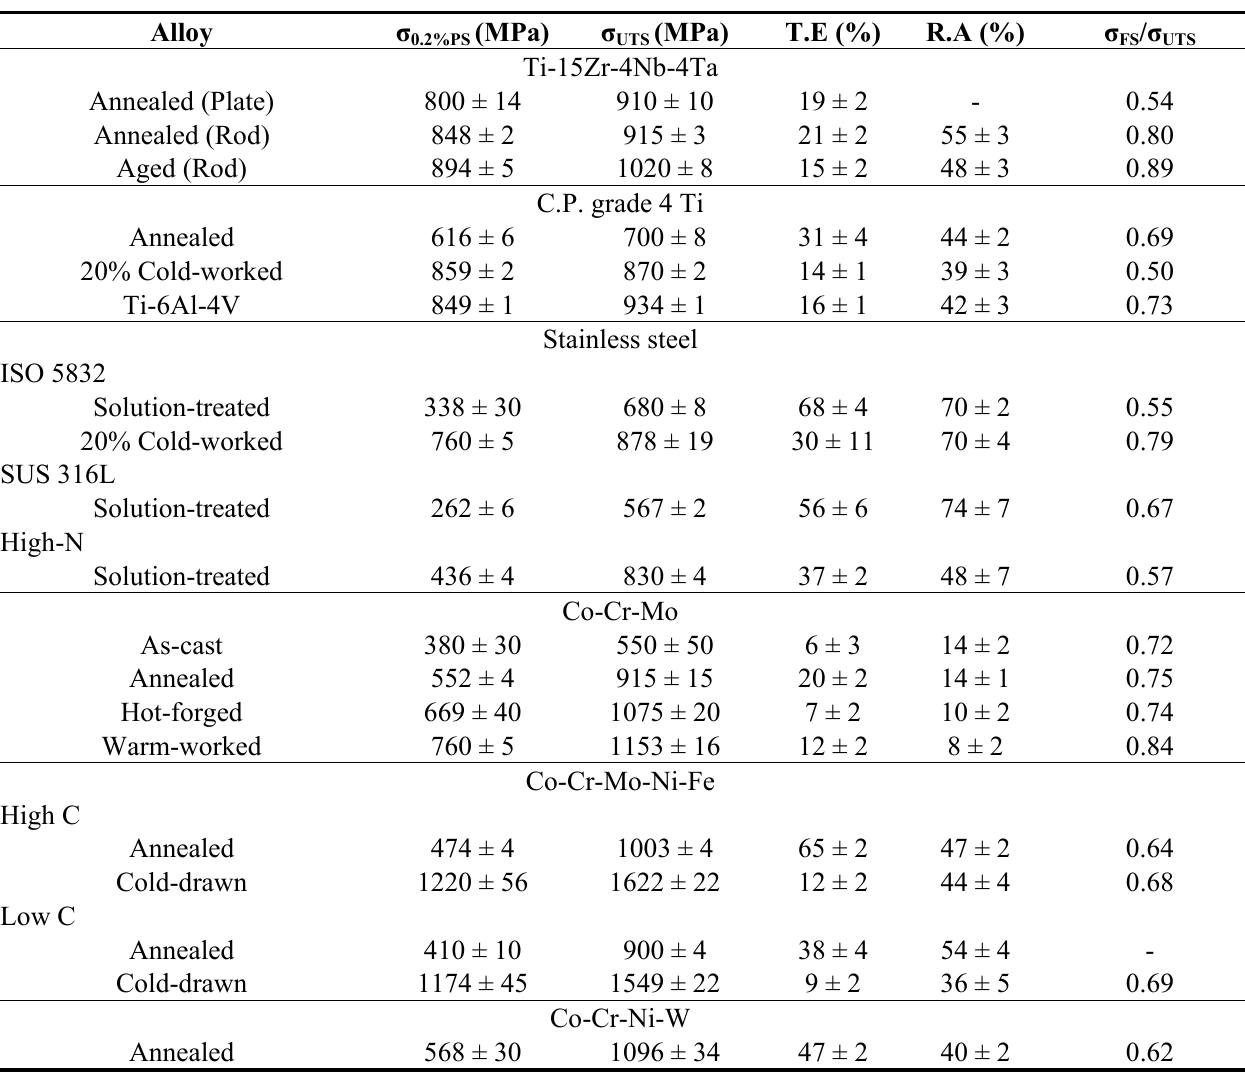
) to σ among alloys. FS UTS